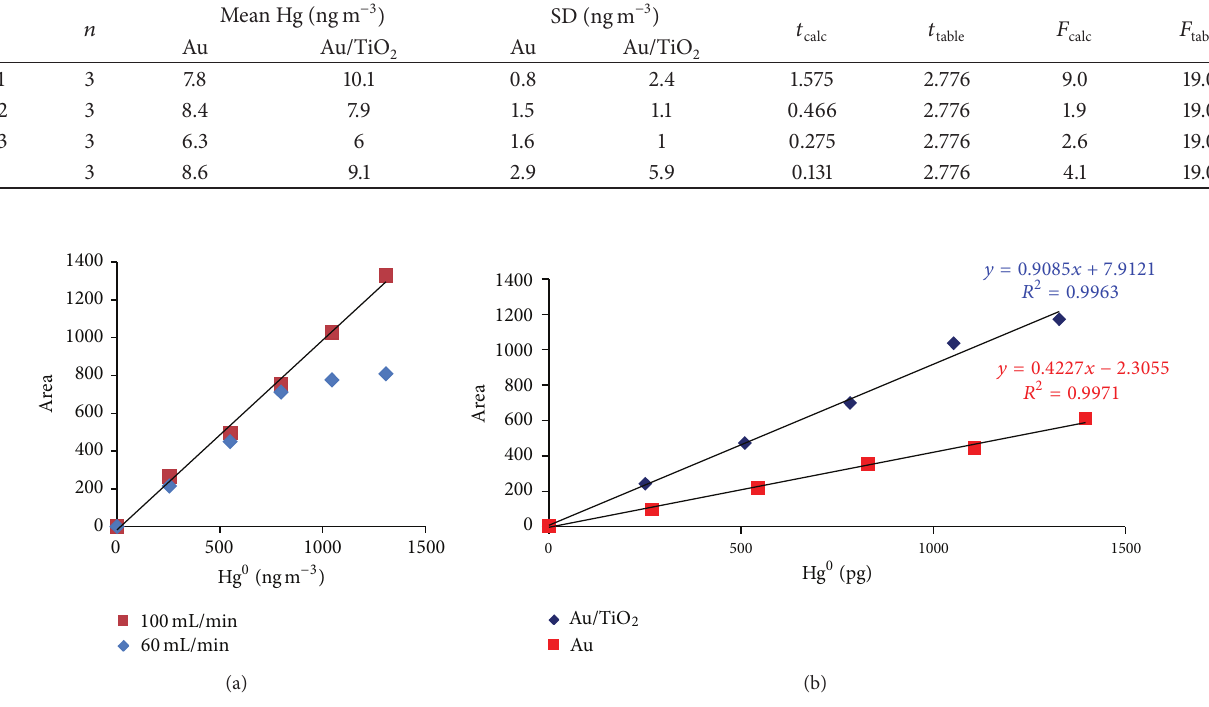
Figure 6: Calibrations obtained with Au-TiO 2 at different Ar flows (a) and with Au and Au-TiO 2 at Ar flow of 100 mLmin −1 (b).